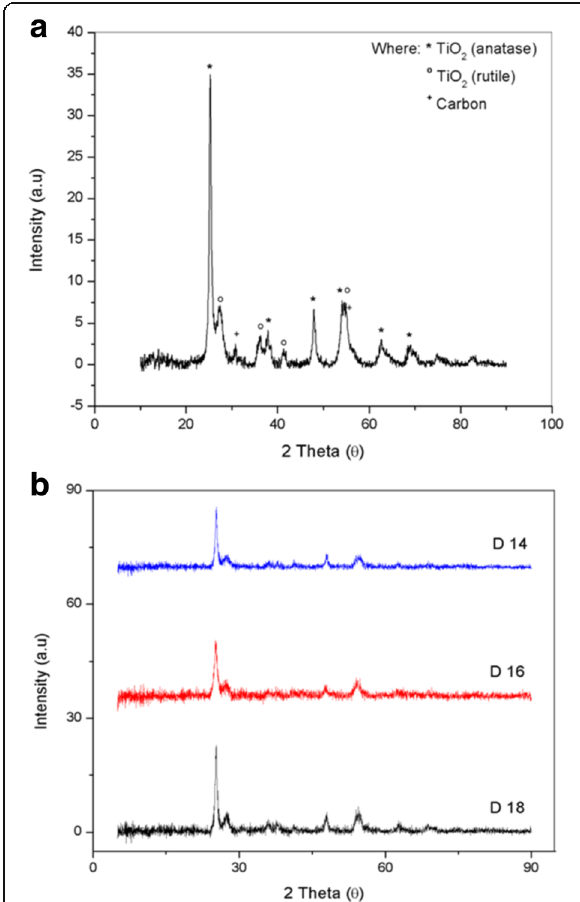
Fig. 7 X-ray diffraction patterns of a individual TiO 2 -CNF sample and b different DTC sample